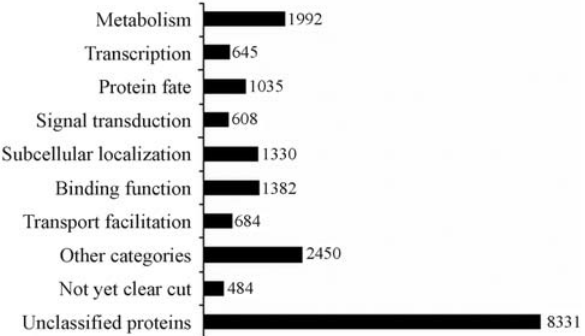
Figure 1 - Overview of the Citrus sinensis expressed sequences in flavedo. The data here represents a subset of the global CitEST project categorization. CitEST Project